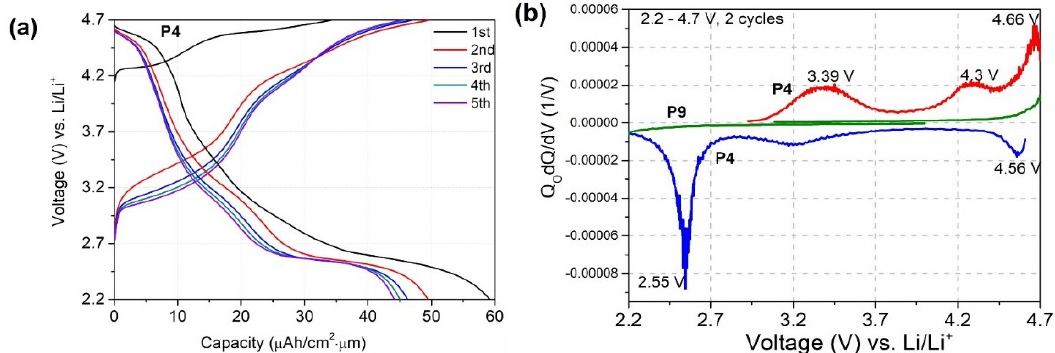
Figure 2. ( a ) Charge/discharge curves of the thin film deposited at the best position (P4) from one to five cycles and ( b ) function of differential capacity of the thin films deposited at the best (P4) and worst (P9) positions.